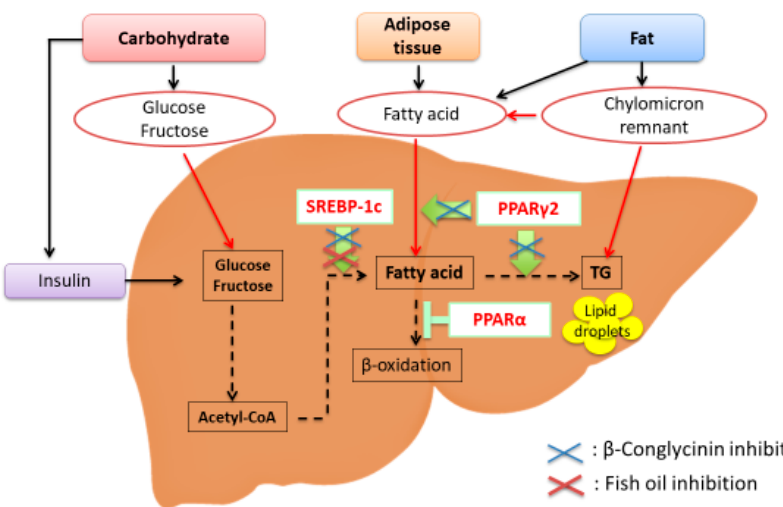
Figure 1. Transcription factors involved in the etiology of nonalcoholic fatty liver disease (NAFLD). Sterol regulatory element-binding protein-1c (SREBP-1c) is a transcription factor that stimulates the expression of de novo lipogenesis-related genes. Peroxisome proliferator-activated receptor γ 2 (PPAR γ 2) is involved in lipid metabolism, and PPAR γ 2 expression is greatly increased in response to a high-fat diet, especially a diet that is high in saturated fatty acids. PPAR α is responsible for fatty acid oxidation. β -Conglycinin downregulates SREBP-1c and PPAR γ 2 (blue crosses). Fish oil downregulates SREBP-1c (red cross).